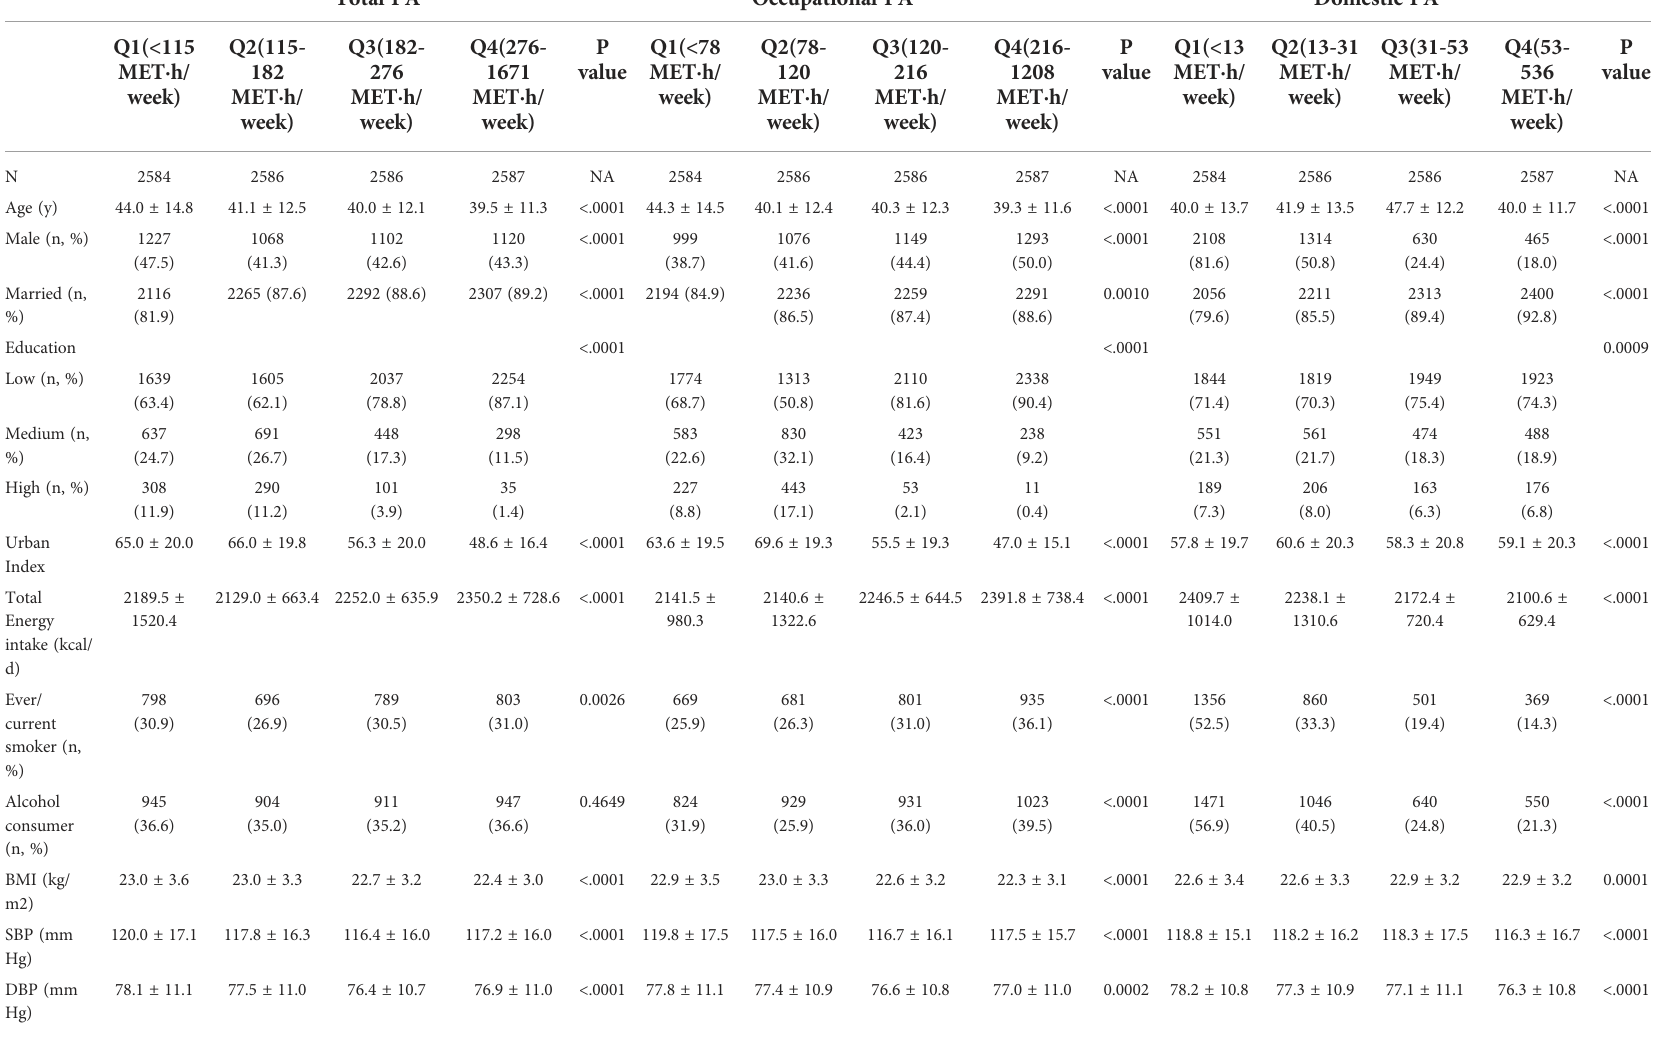
TABLE 1 Baseline characteristic of the study